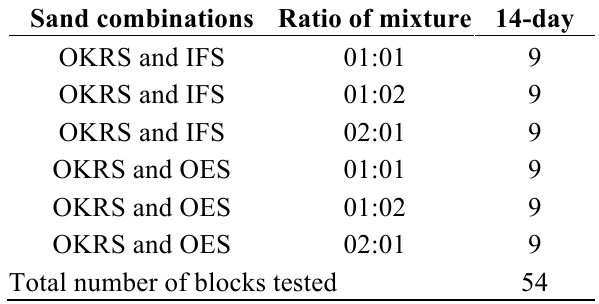
Table 4. Number of 225 mm blocks at the 14-day testing period of various sand combinations for the wet compressive strength.